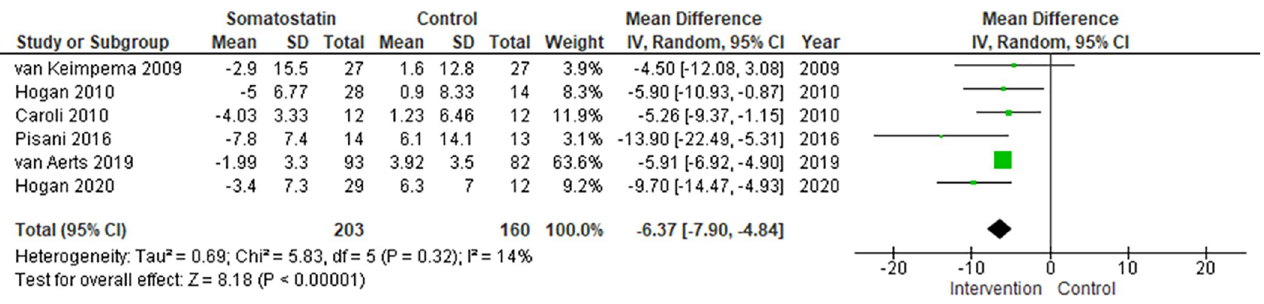
Fig 2. Meta-analysis of TLV.